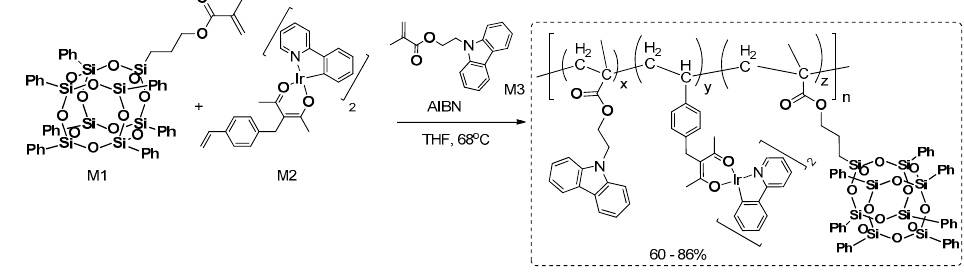
Figure 40. The synthetic route of the copolymer-based Ir complex.